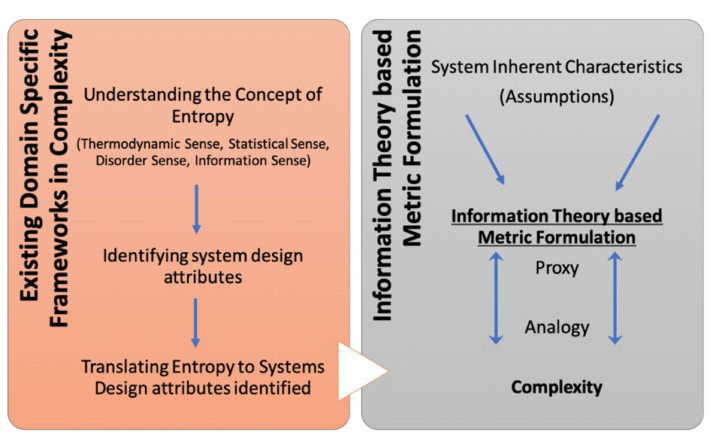
Figure 1. Agnostic two-stage complex systems examination